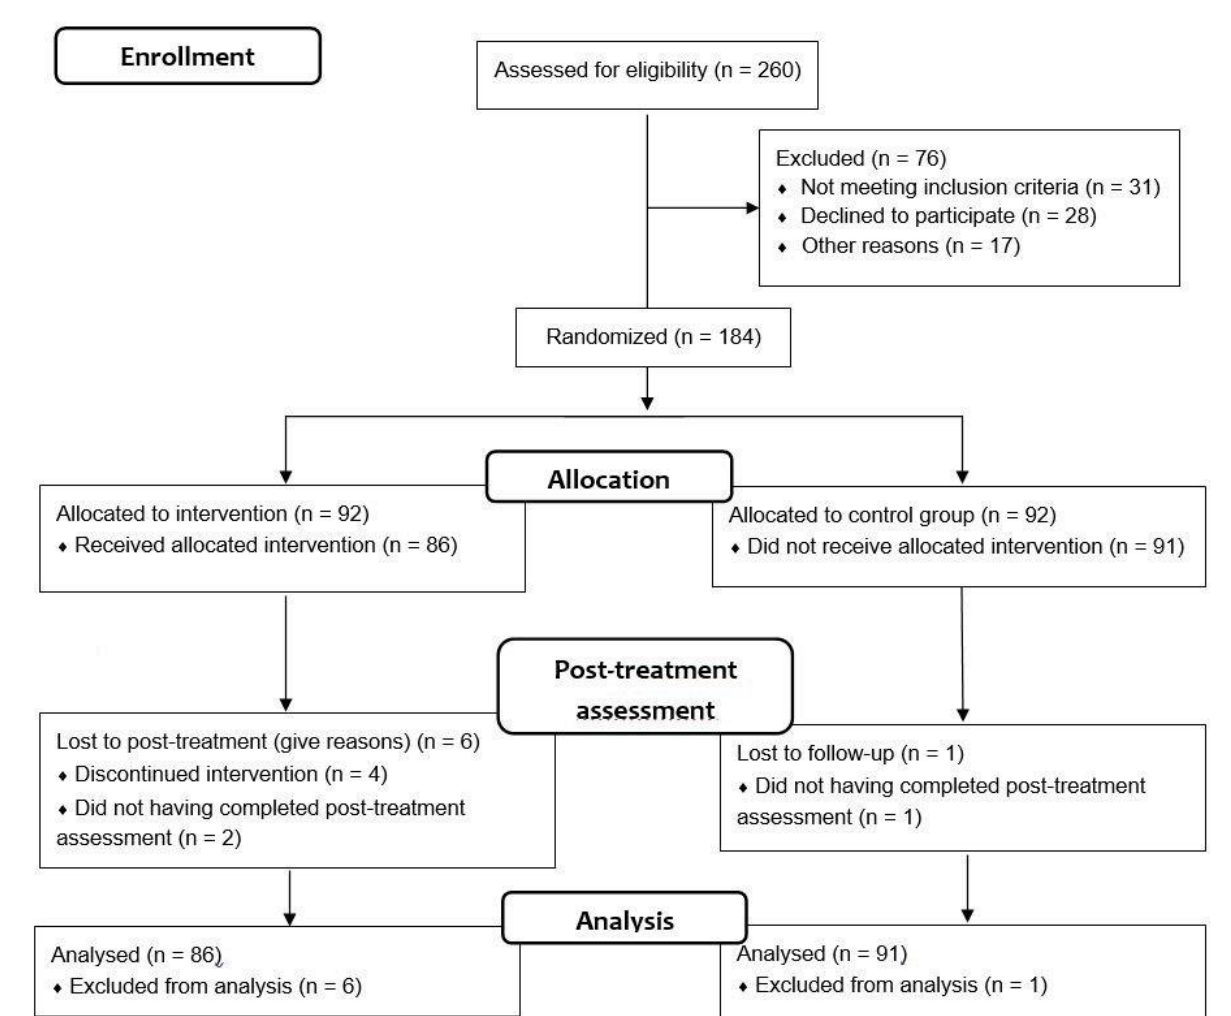
Figure 1. The CONSORT flow diagram.